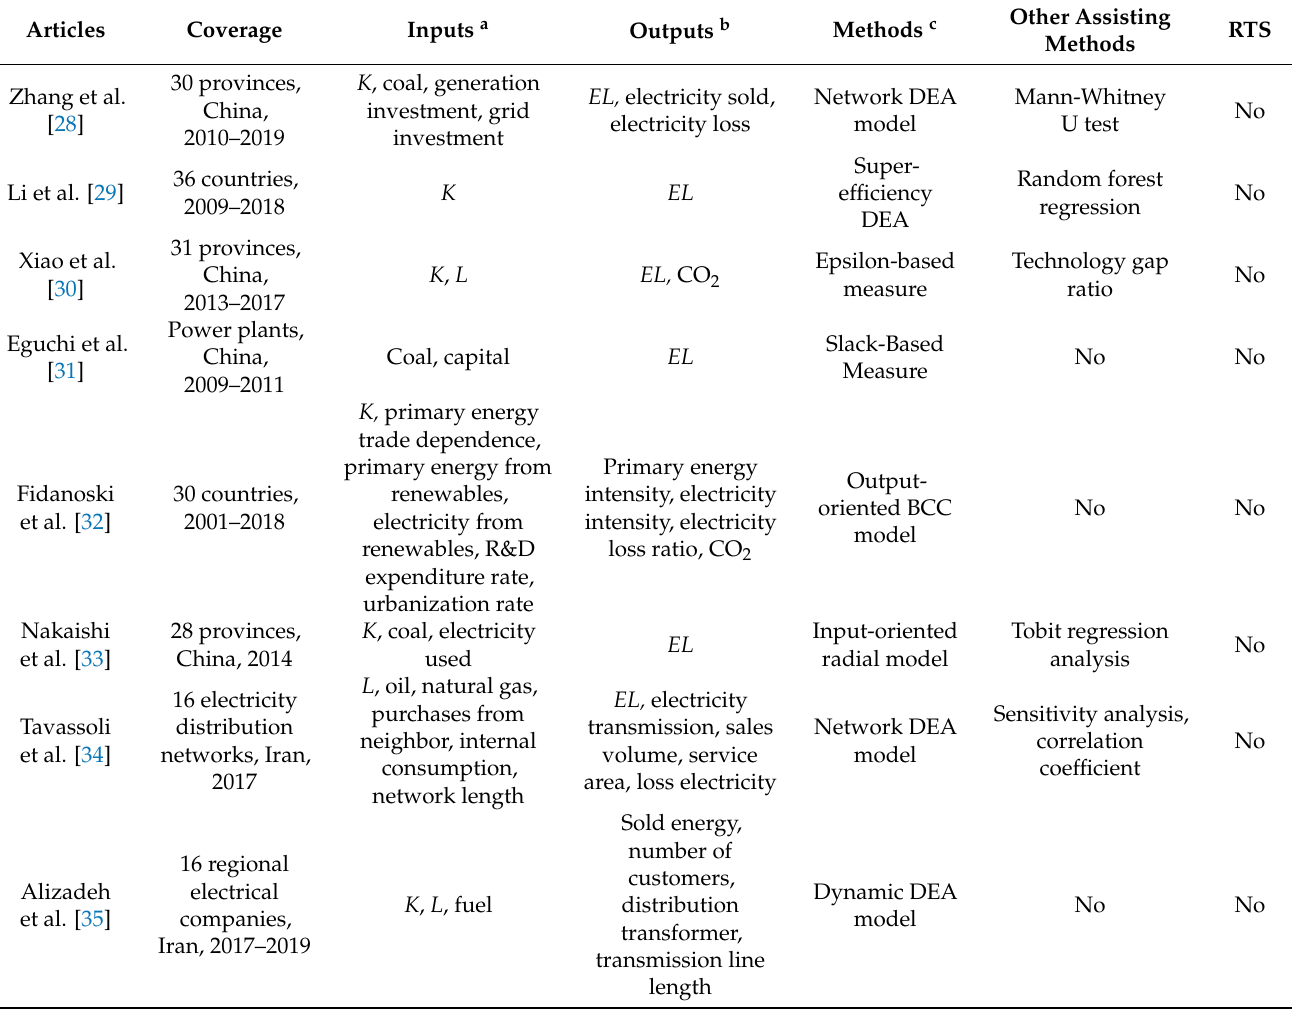
Table 2. Recent studies on electricity generation or transmission based on DEA